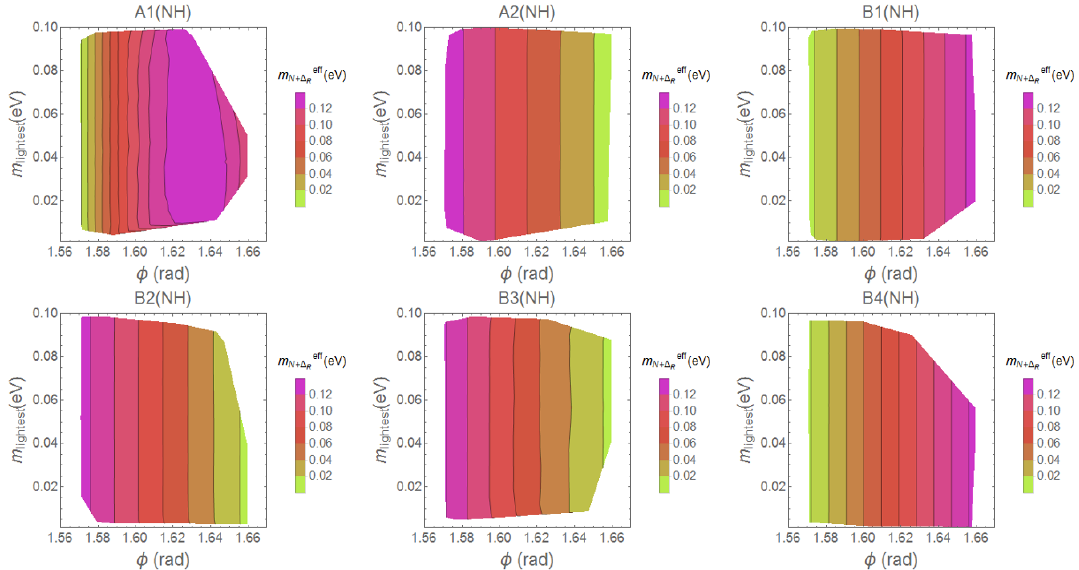
JHEP02(2019)129 Figure 2 . New physics contribution to e(cid:11)ective mass governing NDBD for di(cid:11)erent classes of two zero textures for NH shown as a function of two parameter m lightest and (cid:30) . The contour represents the e(cid:11)ective Majorana mass where 0.061 eV is the KamLAND-Zen upper limit. Figure 3 . New physics contribution to e(cid:11)ective mass governing NDBD for di(cid:11)erent classes of two zero textures for IH shown as a function of two parameter m lightest and (cid:30) . The contour represents the e(cid:11)ective Majorana mass where 0.061 eV is the KamLAND-Zen upper limit. { 17